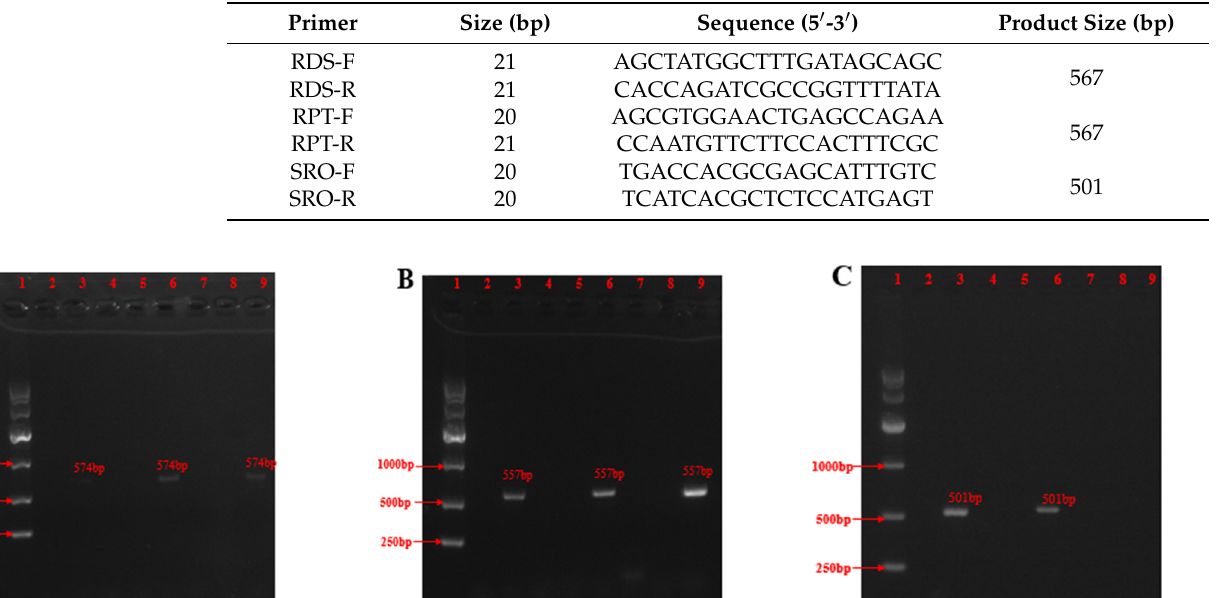
Table 1. Primers used as biological probes.